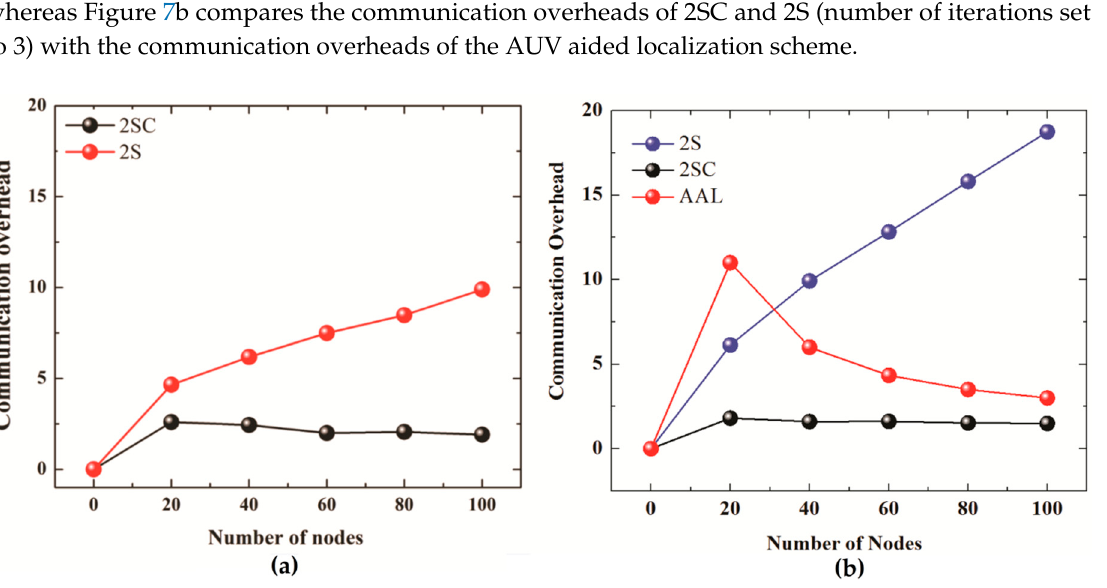
Figure 7. ( a ) Communication overhead for No. of iterations = 2. ( b ) Communication overhead for No. of iterations = 3 (2S, 2SC), AUV Aided Localization.